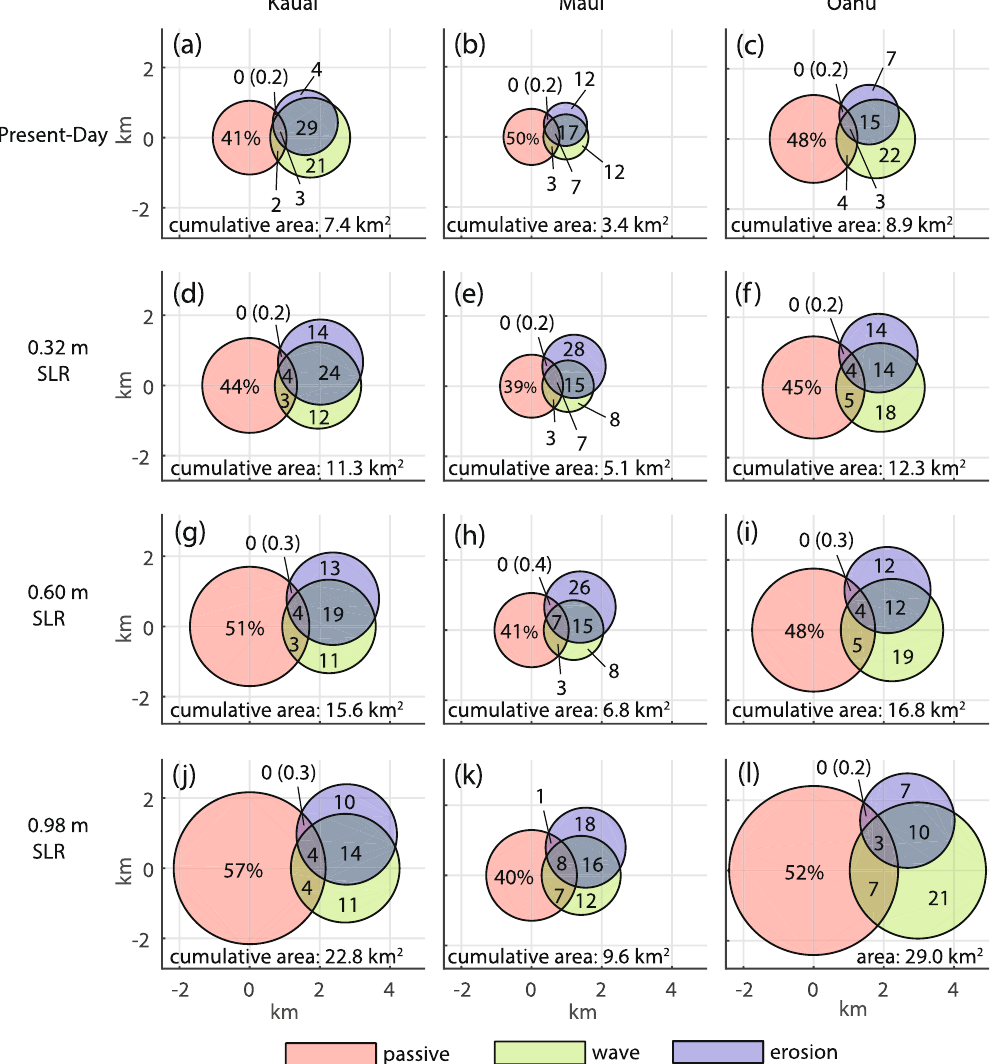
Figure 5. The relation between area exposed to passive flooding (red; includes both marine overland flooding, and groundwater/storm drain flooding), wave inundation (blue), and erosion (green) is shown as Venn diagrams. Each intersecting region represents the land area exposed to the corresponding combination of hazards. The percent of land area represented by each region is displayed in the diagram (the precision to one decimal is also shown in parenthesis, for percentages that round to zero). The land area that is exposed to one or more hazards (cumulative area, or union between all land areas) is given at the bottom of each diagram. Diagrams are shown for the ( a – c ) present-day scenario, ( d – f ) 0.32 m, ( g – i ) 0.60 m, and ( j – l ) 0.98 m SLR